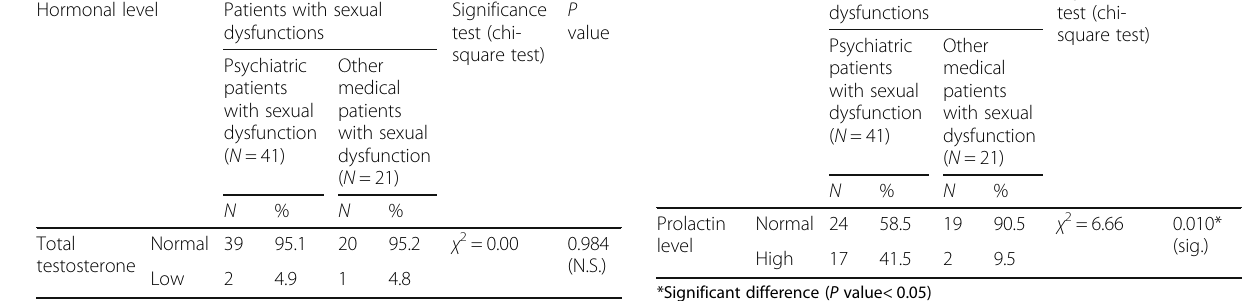
Table 14 Comparison of total testosterone level among psychiatric patients with sexual dysfunctions and other medical patients with sexual dysfunctions Hormonal level